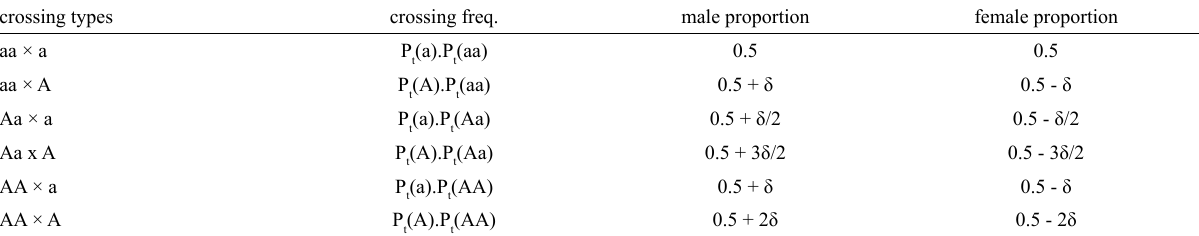
Table 4 ‒ Population frequencies of crossing types and progeny sex proportions. A is an X-linked mutant allele responsible for a distortion in the sex- ratio depending on the number of copies present in the parental pair. It is assumed that the (A, a) locus is randomly inactivated among females (model 6). crossing types crossing freq. male